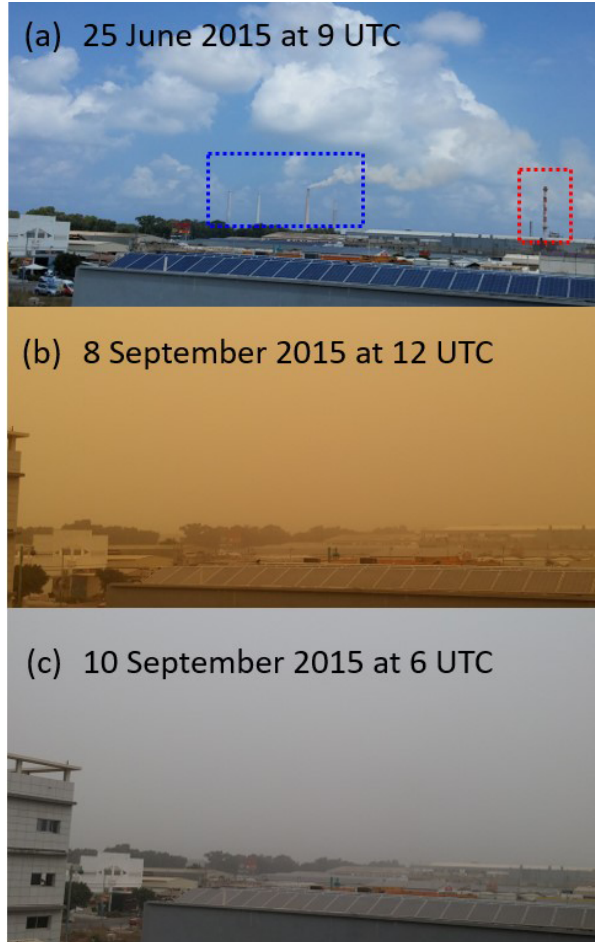
Figure 1. Photographs taken from the central coast of Israel, adja- cent to the Hadera ceilometer, 3.5km southeast to stacks of a power plant (indicated by a blue rectangle) and 600m north to a factory stack (indicated by a red rectangle). The photographs were taken prior to the dust storm, on 25 July 2015 (a) , and during the dust storm, on 8 September 2015 (b) and 10 September 2015 (c) . Notice that the stacks that are visible on a clear day (a) are invisible during the dust storm (b, c) .